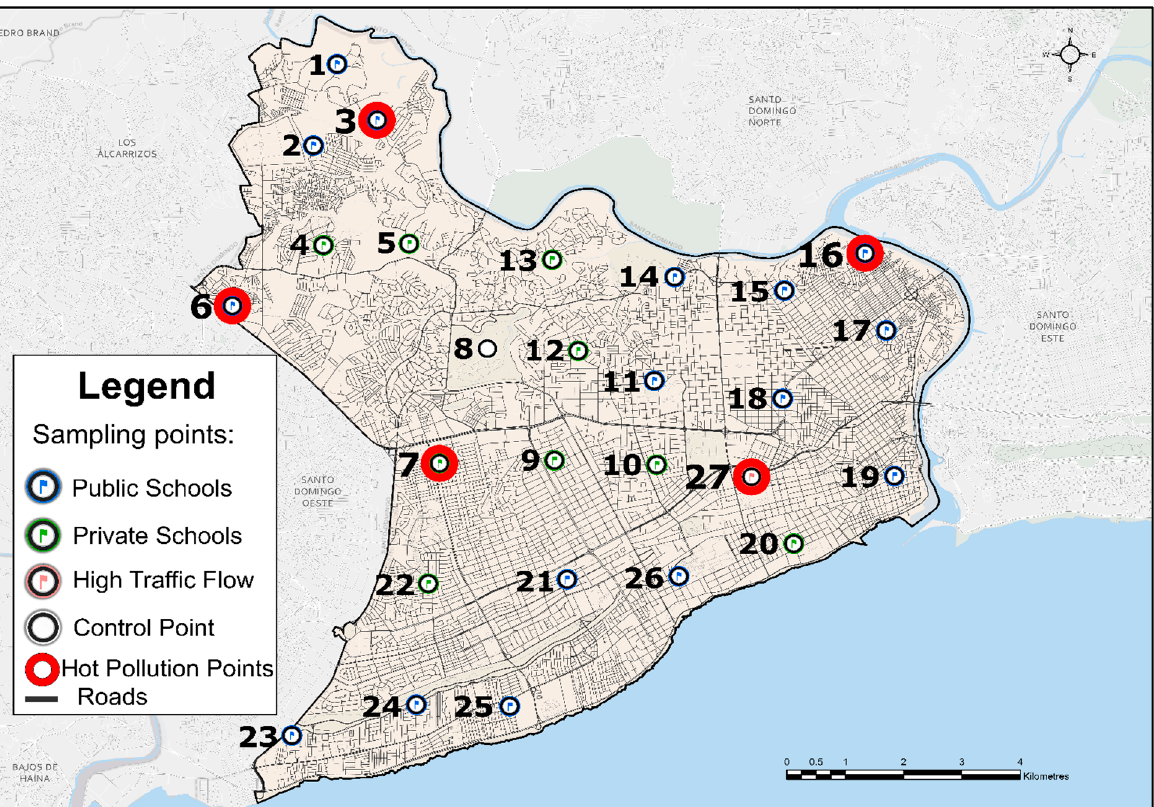
Figure 2. Sampling points and hot pollution points in Santo